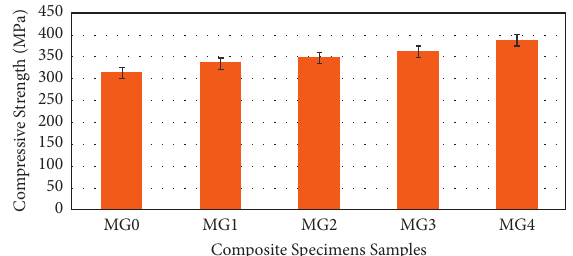
Figure 8: Variation on compressive strength of composite specimens.